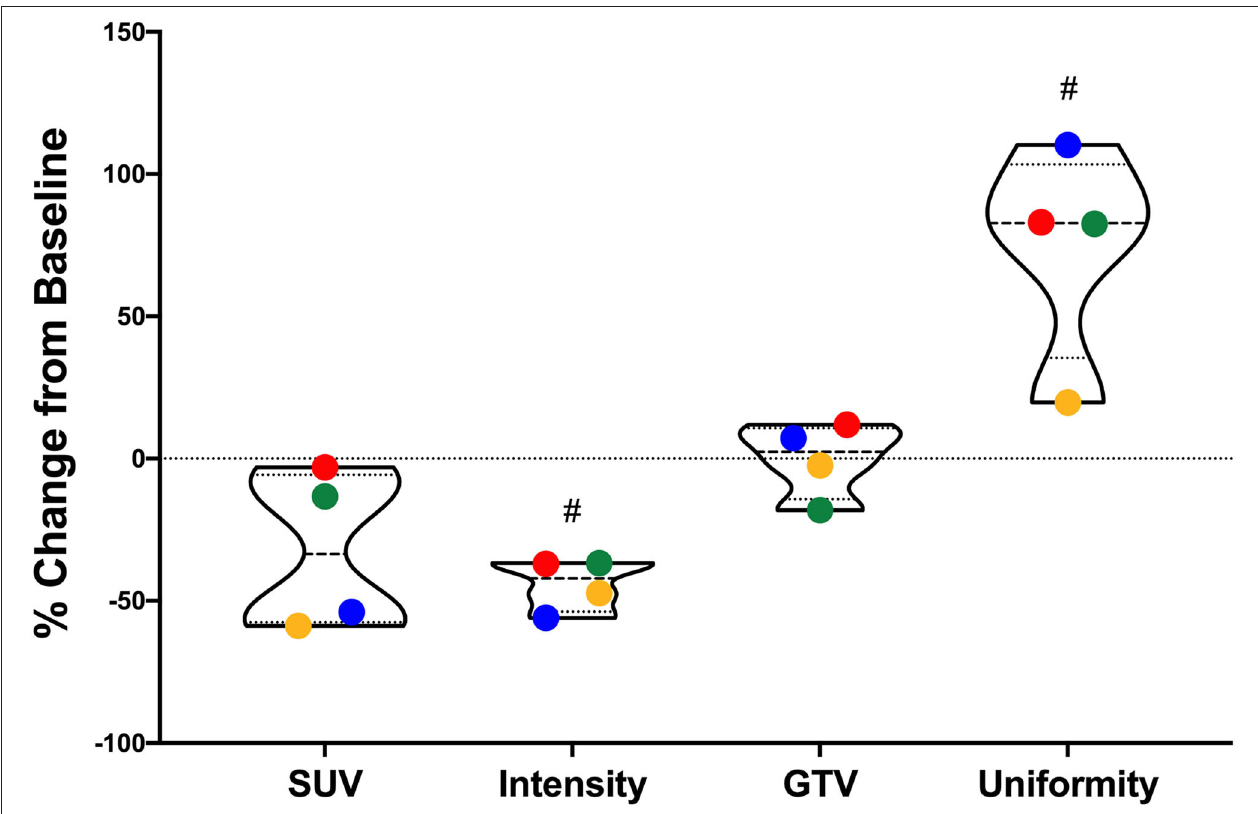
FIGURE 5 | 18 F-FDG PET scan values from dogs receiving zoledronate and coarse fraction radiation therapy for their primary bone tumors. Percent changes from baseline for standard uptake value (SUV), count intensity, gross tumor volume (GTV), and count uniformity are shown. Maximum intensity significantly decreased in all irradiated dogs ( p = 0.013); maximum SUV decreased, but not significantly ( p = 0.11). GTV was not statistically different pre- and post-therapy. Tumors became more uniform after therapy ( p = 0.017). # Significant difference between pre- and posttreatment measurements ( p < 0.05).